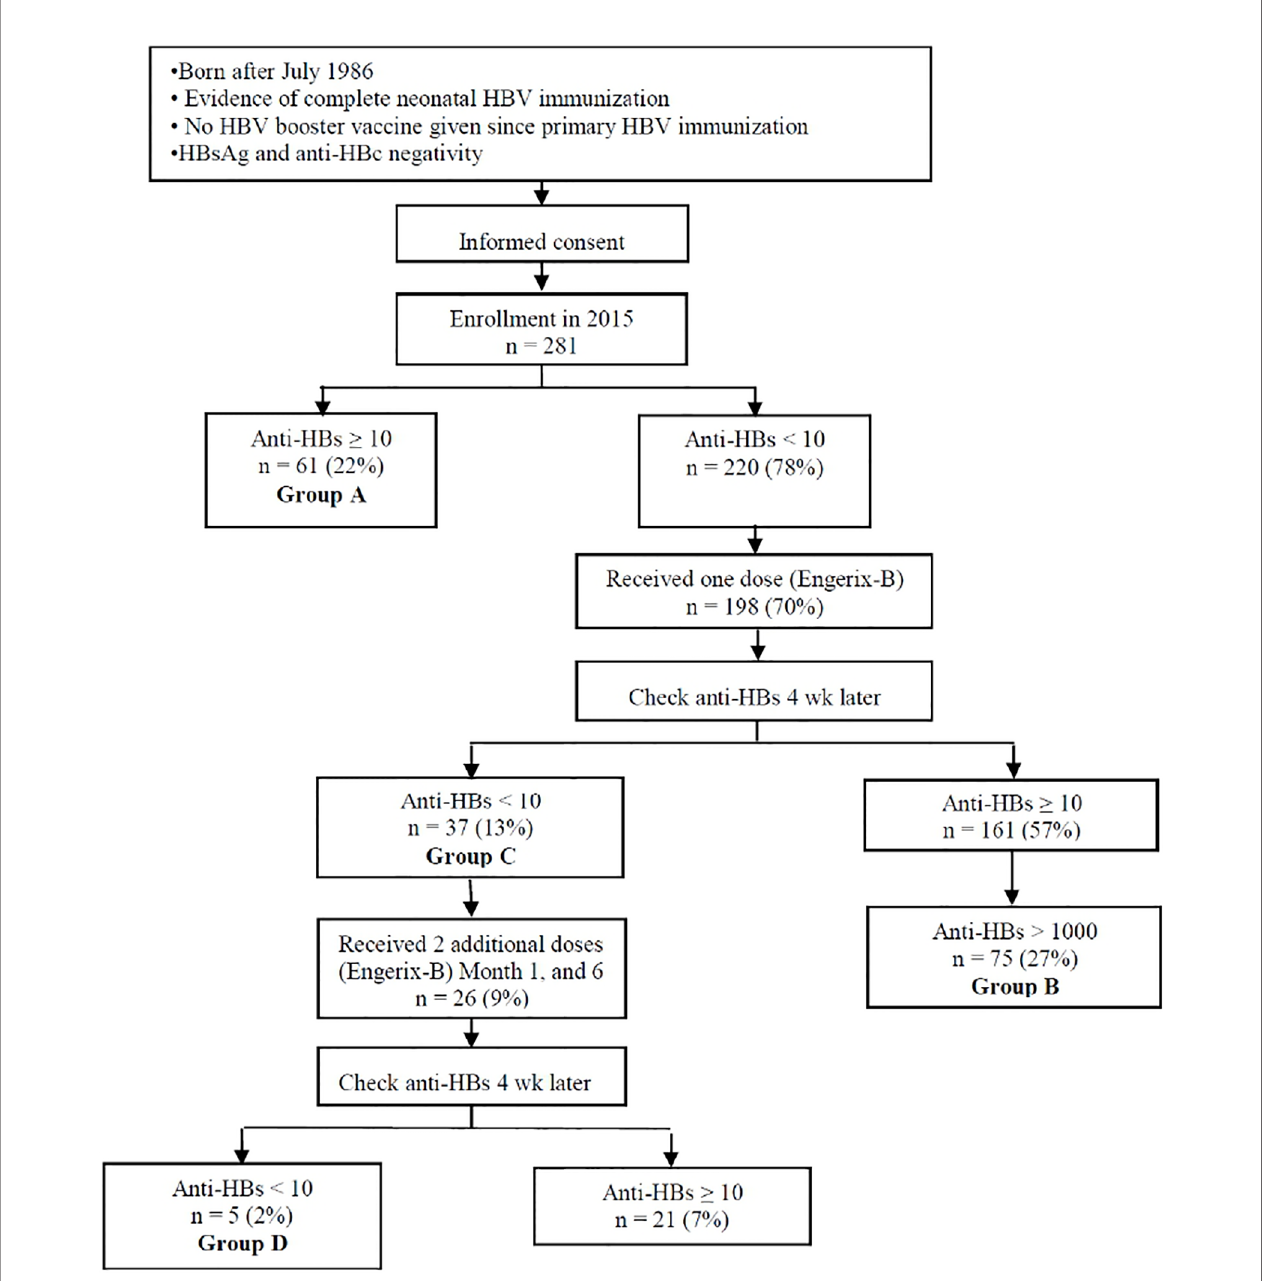
FIGURE 1 | Study fl ow chart. Group A: anti-HBs titer ≥ 10 mIU/mL when entering the study; Group B: anti-HBs level > 1000 mIU/mL after the fi rst booster; Group C: anti-HBs level < 10 mIU/mL after the fi rst booster; and Group D: anti-HBs level < 10 mIU/mL after all HBV